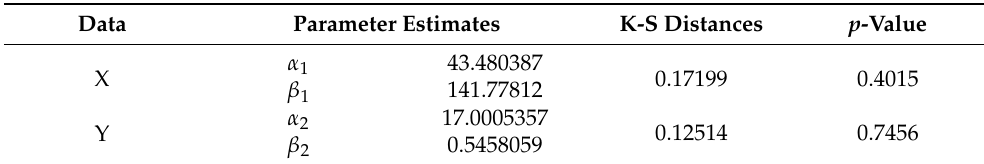
Table 4. Estimations for K-S distances and p -values of margin distribution parameters.